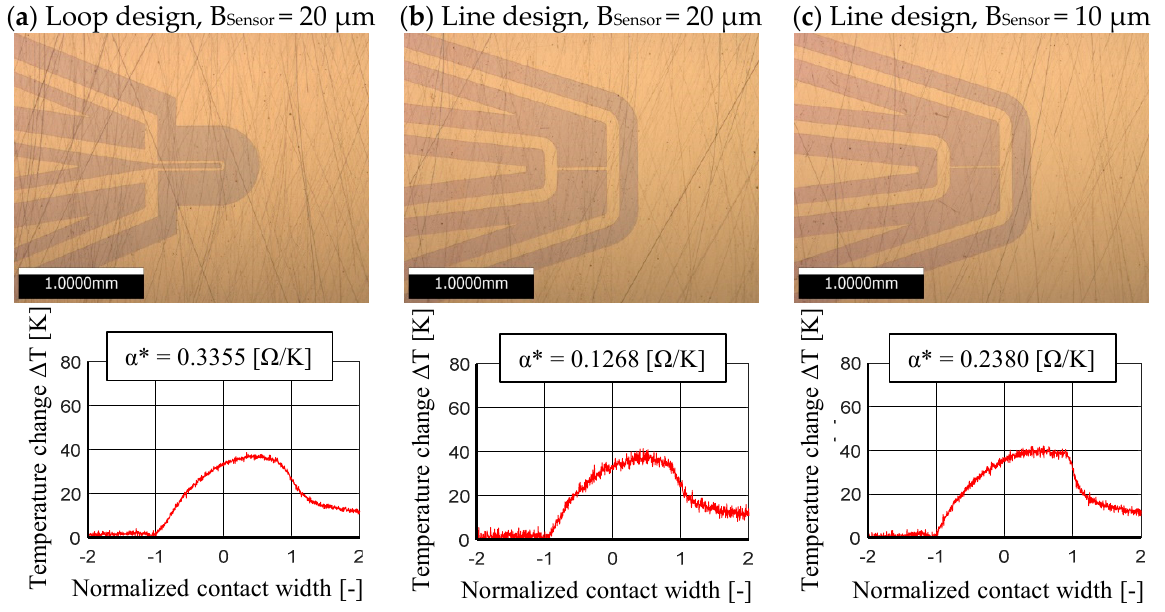
Figure 5. Comparison of different sensor designs at p max 1500 MPa, T Oil 40 °C, v tot 2 m/s, and Slip 40%.